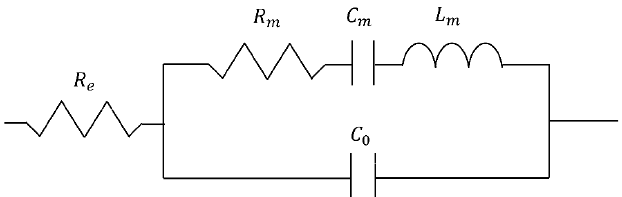
Figure 2. Lumped-element of the Butterworth Van Dyke (BVD) model of the aluminum nitride (AlN) resonator.